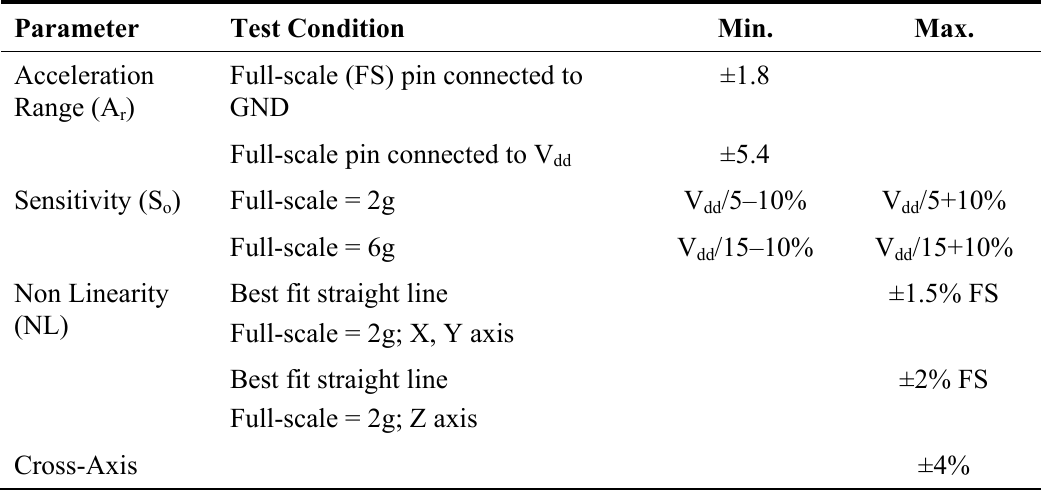
Table 4. Additional electrical parameters for initial